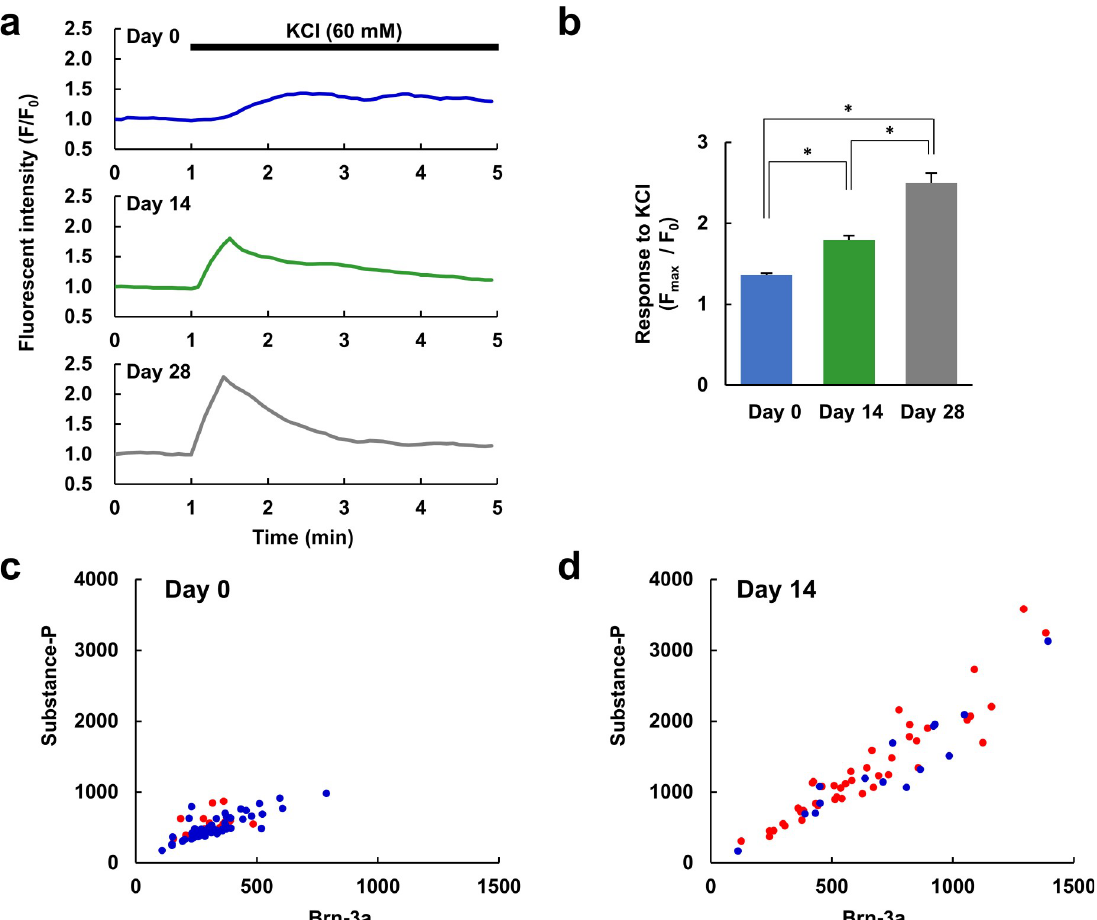
Fig 3. Relationship between neuronal marker expression and Ca 2+ response. (a) Representative Ca 2+ responses to high concentration of KCl (60 mM) in undifferentiated hDPSCs (Day 0, upper) and hDPSCs differentiated for 14 days (Day 14, middle) or 28 days (Day 28, bottom). (b) Comparison of the amplitude (F max /F 0 ) of Ca 2+ responses evoked by KCl in 1 min after application in Day 0, 14 and 28 hDPSCs (n = 69, 58, or 67 cells, respectively, from 3 different experiments for each condition). � P < 0.05 between the indicated pairs. The cells were fixed immediately after Ca 2+ imaging and immunostained. (c, d) Immunofluorescence intensity of substance-P and Brn-3a of each cell cultured in differentiation medium for 0 days (Day 0, n = 69 cells) (c) and 14 days (Day 14, n = 58 cells) (d). In panels c and g, red dots indicate cells that exhibited a large response to KCl (F max /F 0 > 1.5); blue dots indicate cells that exhibited a small or no response to KCl (F max /F 0 <